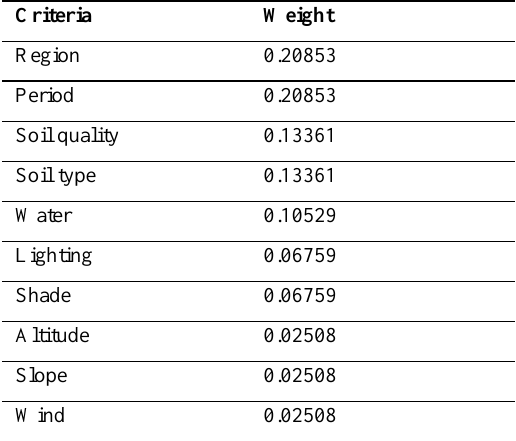
Table 4. Weights of different